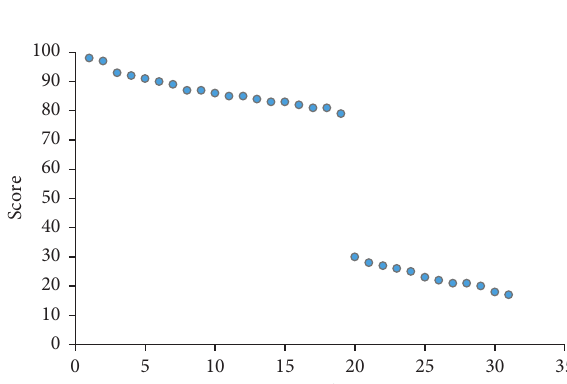
Figure 5: Distribution of RD+.